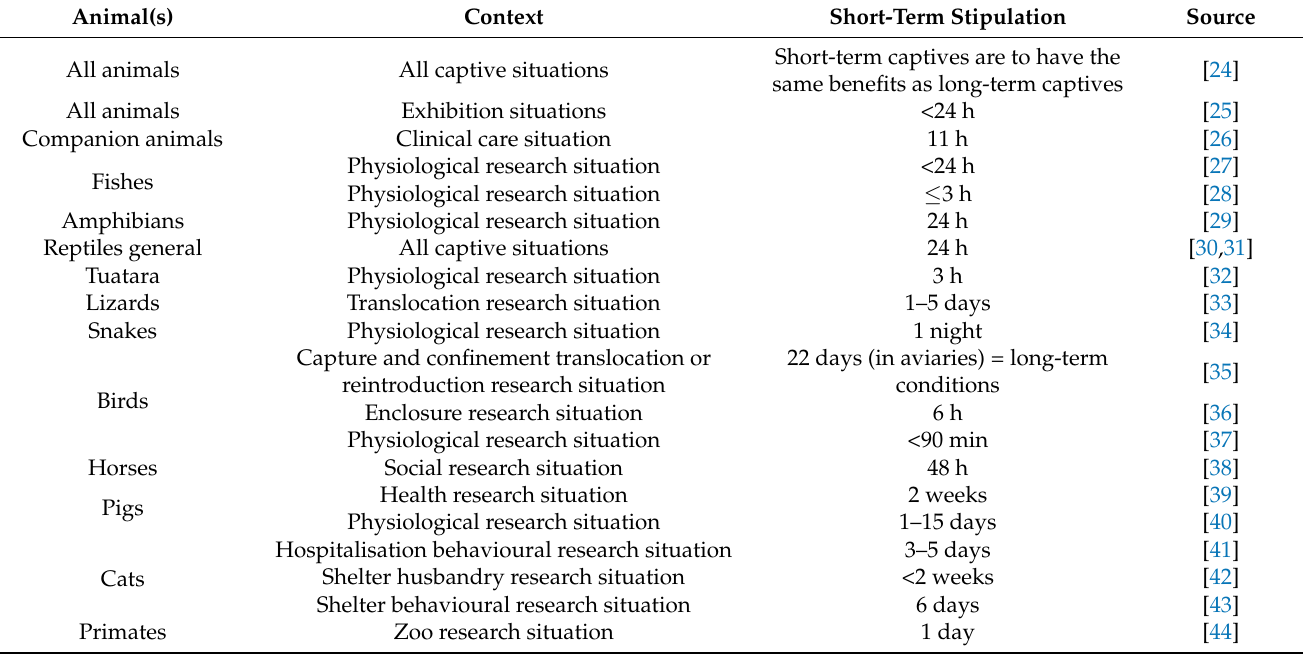
Table 2. Short-term (including ‘temporary’ or ‘transitional’) confinement for animals: scientific criteria or guidance from peer-reviewed academic